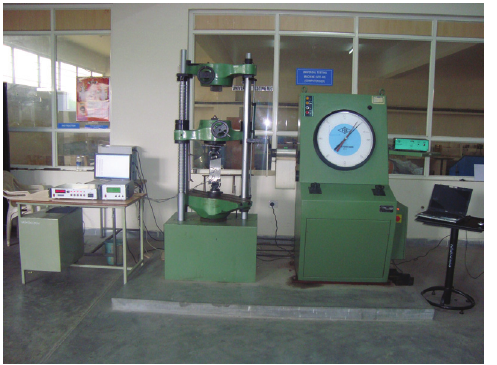
Figure 3 The experimental